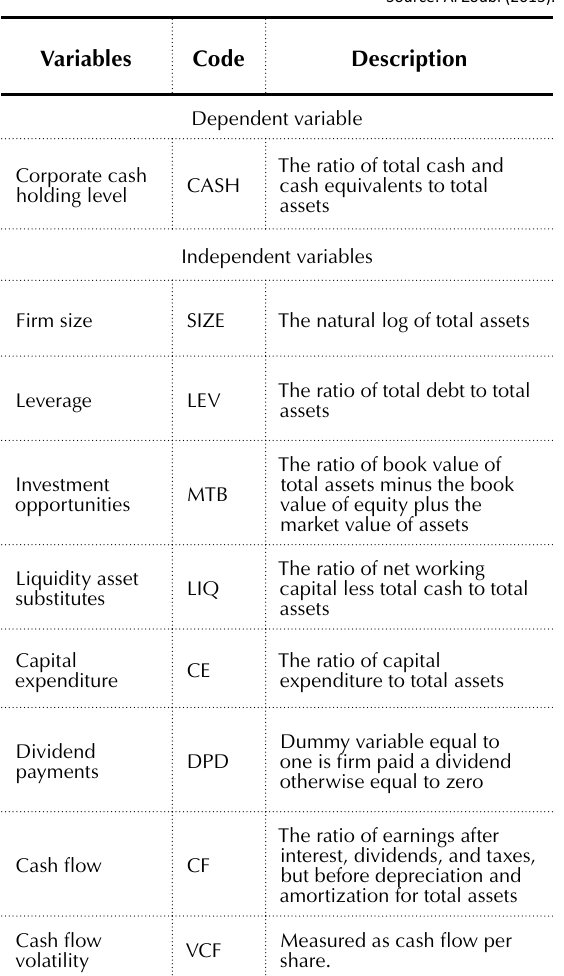
Table 1. Description of study